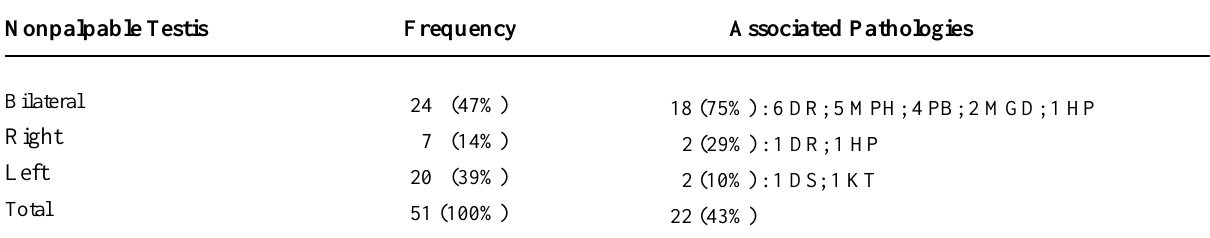
Associated Pathologies